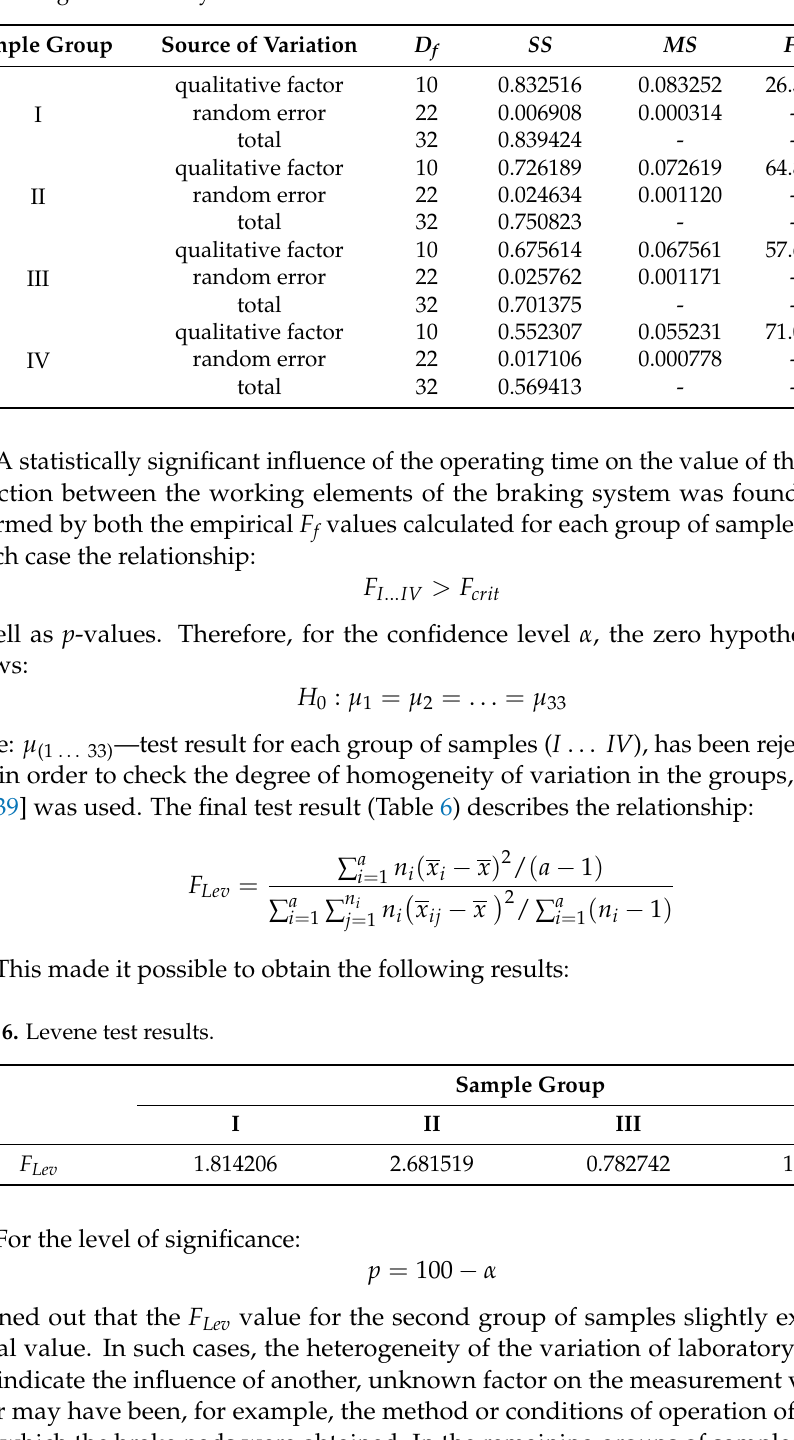
Table 5. Single-factor analysis of variance calculation results.